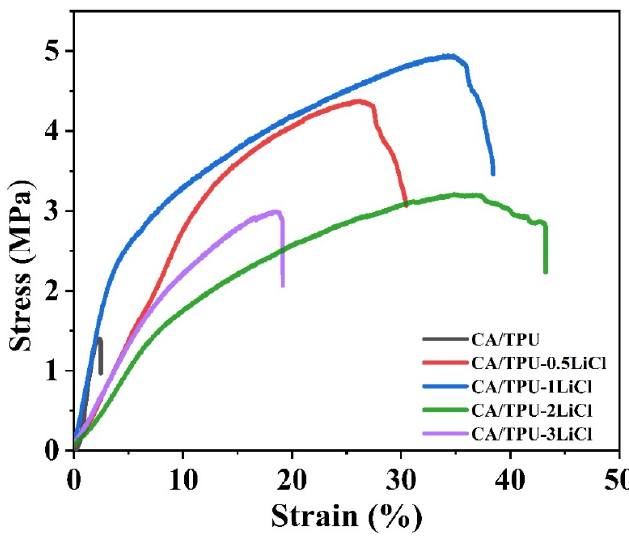
Figure 5. Stress ‐ strain curves of each CA/TPU ‐ xLiCl fiber membrane. Figure 5. Stress-strain curves of each CA/TPU-xLiCl fiber